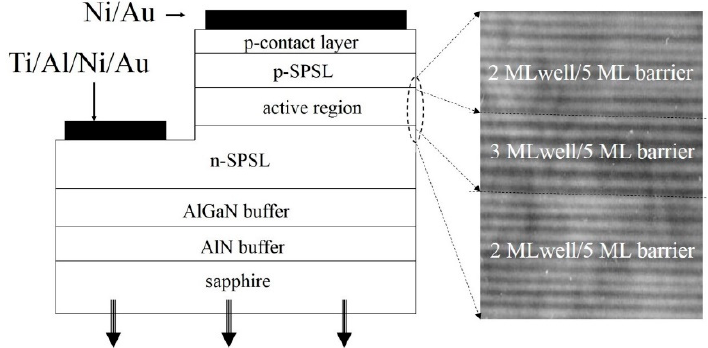
Figure 9. A not-in-scale schematic cross-section (on the left ) of a double heterostructure (DHS) light-emitting diode (LED) and TEM cross-section (on the right ) of the active region, and adjacent n- and p-type emitters of this diode.